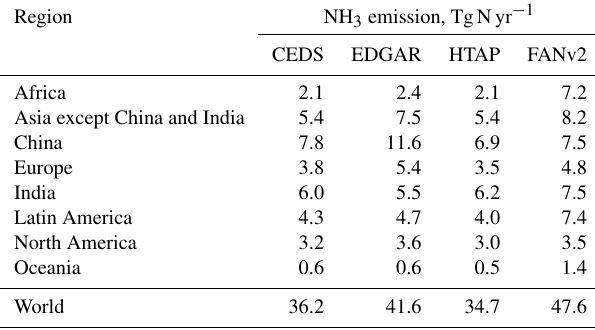
Table 1. Agricultural ammonia emissions by region in the FANv2 simulation and in the CEDS, EDGAR 4.3.2 and HTAP_v2.2 inven- tories. The FANv2 emissions are averaged for 2010–2015; the other emissions are for the year 2010. The totals are interpolated from gridded emissions; the European emissions include the part of Rus- sia west of 60 ◦ E.